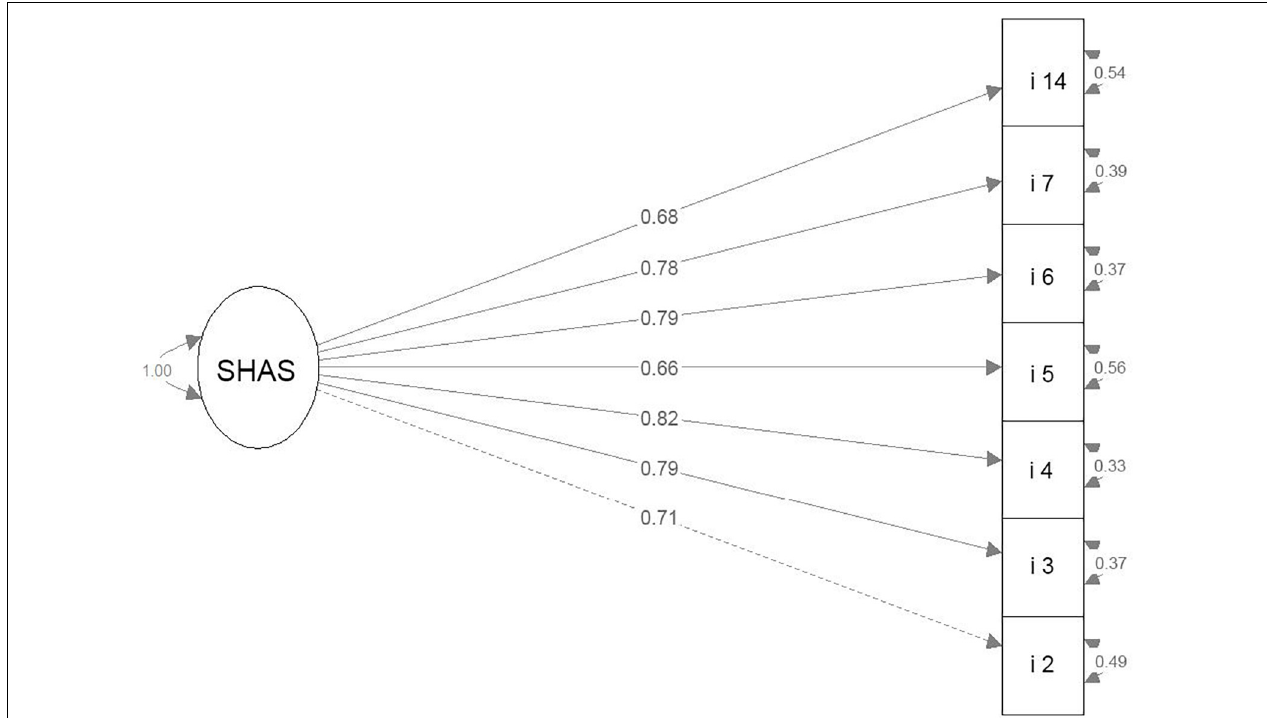
FIGURE 1 | The optimal for the Russian sample CFA model tested for the Short Home Attachment Scale .